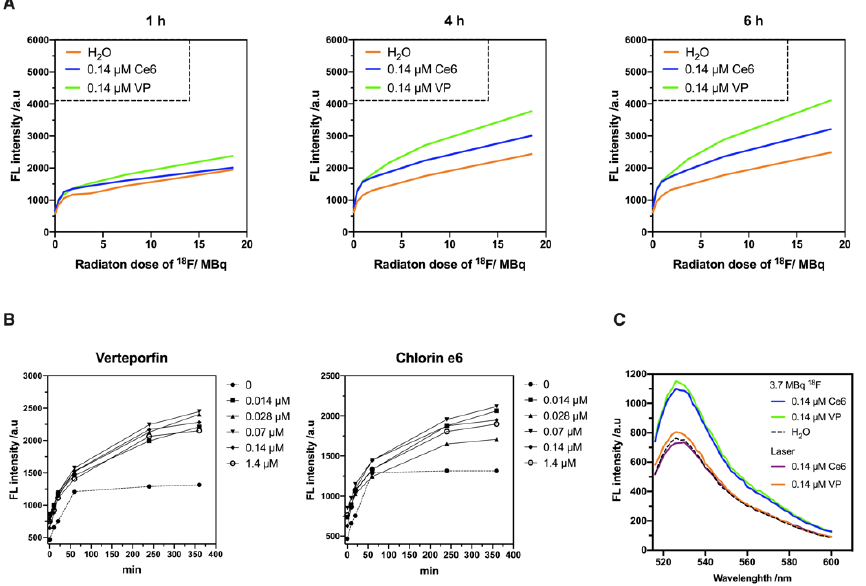
Figure 2 . Evaluation of 18 F-emitted CR-induced photoexcitation. In all experiments, SOSG, a fluorescent probe, was used for 1 O 2 detection. ( A ) Fluorescence spectra ( λ ex = 504 nm) were recorded when different doses of 18 F were incubated with fixed concentrations of Chlorin e6 and Verteporfin, respectively, until 6 h. ( B ) Comparison of Chlorin e6 and Verteporfin with varied concentrations reacting with 3.7 MBq of 18 F-FDG in FL intensity at 530 nm. ( C ) Comparison of the fluorescence spectra between CR and laser irradiation induced photoexcitation. For CR, 3.7 MBq of 18 F-FDG was used to react with Chlorin e6 and Verteporfin. For laser irradiation, Chlorin e6 and Verteporfin were exposed under the laser pointer with emission wavelength of 650 ± 10 nm.